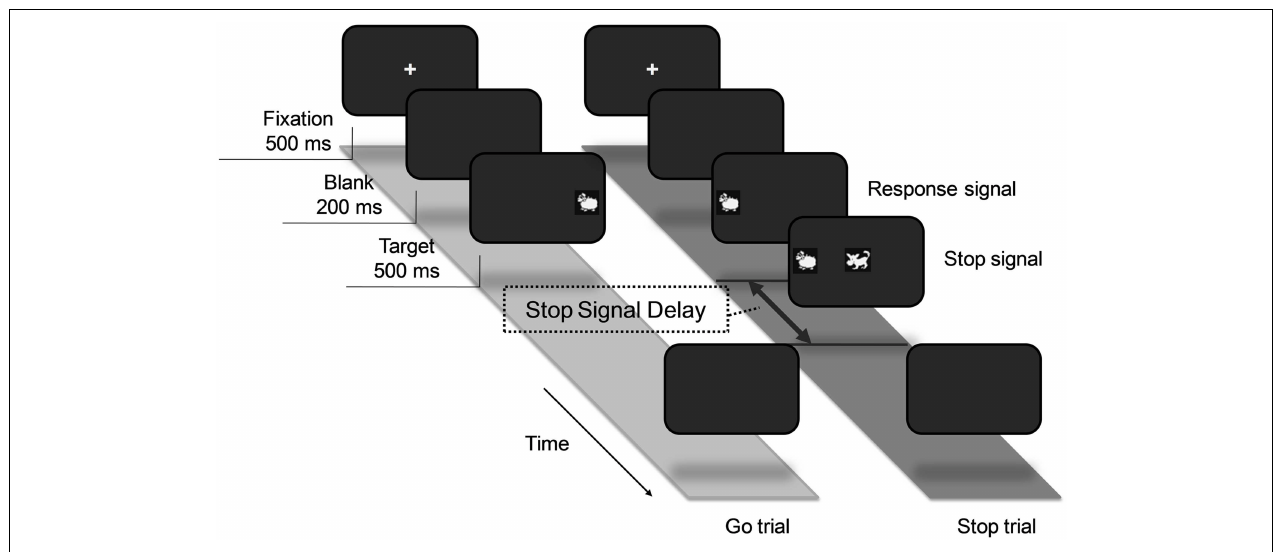
FIGURE 1 | Experimental procedure of the stop-signal task for children. The task consisted of go and stop trials. All trials began with a central fixation cross and were followed by a sheep to either the left or right